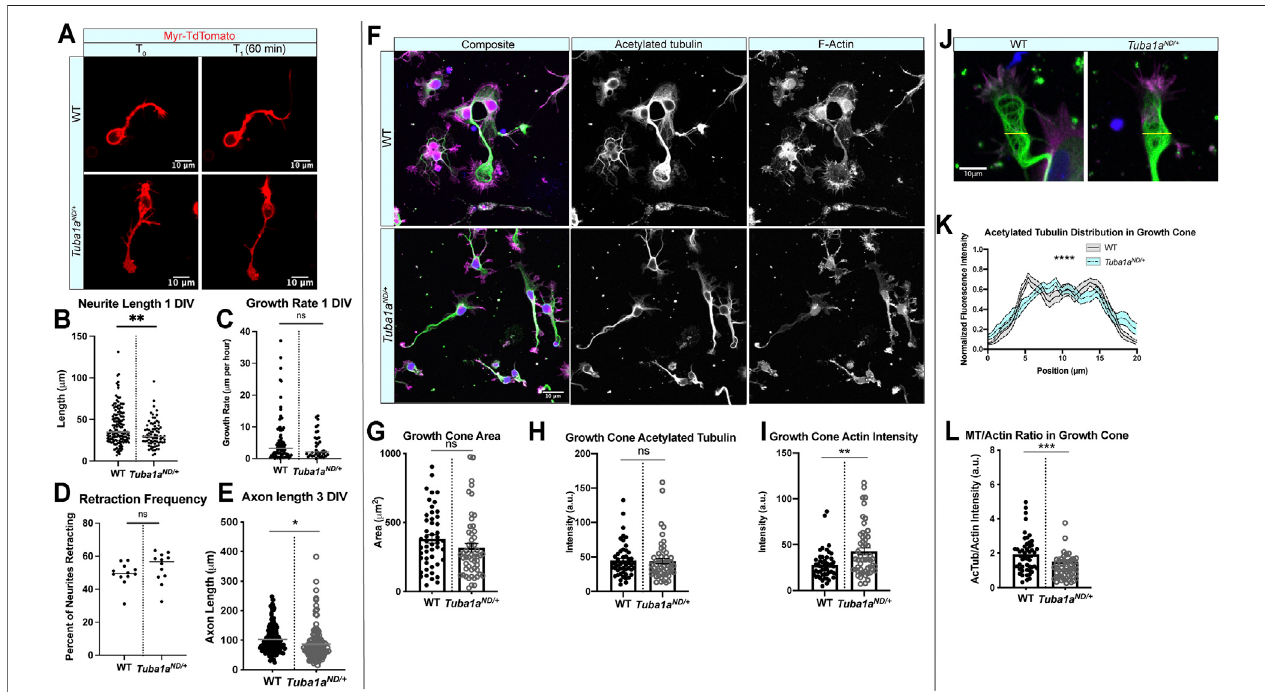
FIGURE 5 | Tuba1a ND impairs neurite outgrowth and alters growth cone cytoskeleton in cortical neurons. (A) Representative time-lapse images of membrane- labeled Myr-TdTomato neurons at DIV 1. Myr-TdTomato images were acquired 60 min apart to assess neuronal growth rate in wild-type (WT; top) and Tuba1a ND/+ (bottom) cortical neurons. (B) Neurite lengths from WT and Tuba1a ND/+ mice at DIV 1. Data points represent individual neurons (32.51 ± 1.75 vs. 41.25 ± 1.71 μ m, p (cid:1) 0.0016by t -test, n (cid:1) 157WTneuronsN (cid:1) 13miceand77Tuba1aND/+neurons,N (cid:1) 9mice). (C) ScatterplotofneuritegrowthrateinDIV1neuronsmeasuredover 60 min using Myr-TdTomato tagged primary cortical neurons from WT and Tuba1a ND/+ mice (5.828 vs. 4.064 μ m/h, p (cid:1) 0.1853). (D) Scatter plot of neurite retraction frequencyrevealsatrendtowardmorefrequentretractionsin Tuba1a ND/+ mice(49.25 vs.53.39%, p (cid:1) 0.2247). (E) ScatterplotofneuritelengthatDIV3in fi xedWTand Tuba1a ND/+ primary cortical neurons. For each cell, the longest neurite, designated a putative “ axon ” , was measured from the cell soma to the distal neurite tip using an acetylated tubulin marker. Data points represent individual neurons (N (cid:1) 3 mice, n (cid:1) 124 neurons; p (cid:1) 0.02). (F) Images of DIV 3 WT (top) and Tuba1a ND/+ (bottom) cortical neurons stained with antibodies directed against acetylated tubulin (green) and rhodamine phalloidin (F-actin, magenta). Compositeimages are shown (left) with single channel grayscale images for acetylated tubulin (middle) and F-actin (right). Fluorescent images were post-processed in ImageJ to enhance brightness and contrast, set to a minimum value of 0 and a maximum value of 70. Scale bars are 10 µm. (G) Scatter plot of growth cone area at DIV 3 in WT and Tuba1a ND/+ cortical neurons.Datapointsrepresentindividualgrowthcones(N (cid:1) 3mice, n (cid:1) 52growthcones; p (cid:1) 0.26). (H) Scatterplotofacetylatedtubulinintensitywithinthegrowthcone of WT and Tuba1a ND/+ cortical neurons at DIV 3. Acetylated tubulin images were collected using identical microscope imaging settings between samples, fl uorescence ofquanti fi edimageswasnotadjustedpriortomeasurement. Acetylatedtubulinintensitywasnormalized totheareaofthegrowthcone.Datapointsrepresentindividual growth cones ( n (cid:1) 49 growth cones; p (cid:1) 0.89). (I) F-actin intensity within growth cone of WT and Tuba1a ND/+ cortical neurons at DIV 3. F-actin images were collected using identical microscope imaging settings between samples, fl uorescence of quanti fi ed images was not adjusted prior to measurement. F-actin intensity was normalizedtotheareaofthegrowthcone.Datapointsrepresentindividualgrowthcones(N (cid:1) 3mice, n (cid:1) 49growthcones; p (cid:1) 0.0014). (J) RepresentativeimagesofWT and Tuba1a ND/+ cortical neuron growth cones showing distribution of acetylated tubulin (green) and F-actin (magenta). The yellow line indicates where microtubule fl uorescence intensity measurements were taken. (K) Line plot showing the average acetylated tubulin fl uorescence intensity across a 20 µm line scan through the central domain of the growth cone, taken perpendicular to the extending neurite shaft or putative axon in DIV 3 WT and Tuba1a ND/+ neurons. Differences between WT and Tuba1a ND/+ growth coneswere assessed by two-way ANOVAwhich showed asigni fi cantinteraction between genotype and fl uorescence intensity byposition ( n (cid:1) 20 growth cones; p < 0.0001). (L) . Scatter plot representing the ratio of acetylated tubulin to F-actin intensity within the growth cones of DIV 3 WT and Tuba1a ND/+ cortical neurons. Acetylated tubulin and F-actin intensity was measured from a single ROI in each growth cone, fl uorescent images were acquired using the same microscope settings between samples and were not post-processed to adjust fl uorescence. Data points represent individual growth cones (N (cid:1) 3 mice, n (cid:1) 49 growth cones; p (cid:1) 0.0003 by Mann-Whitney test). For all plots, lines represent mean and error bars report SEM. Differences between WT and Tuba1a ND/+ datasets were assessed by t test unless otherwise noted. * p < 0.05; ** p < 0.01; *** p < 0.001; **** p < 0.0001.